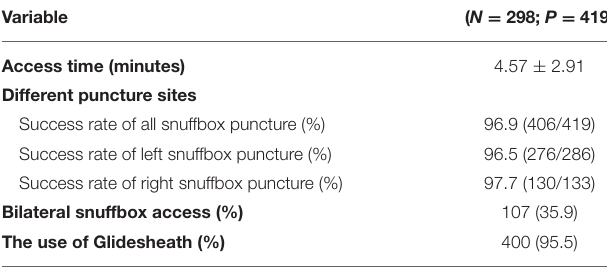
TABLE 1 | Demographics and clinical characteristics. TABLE 2 | Procedural characteristic of the snuffbox